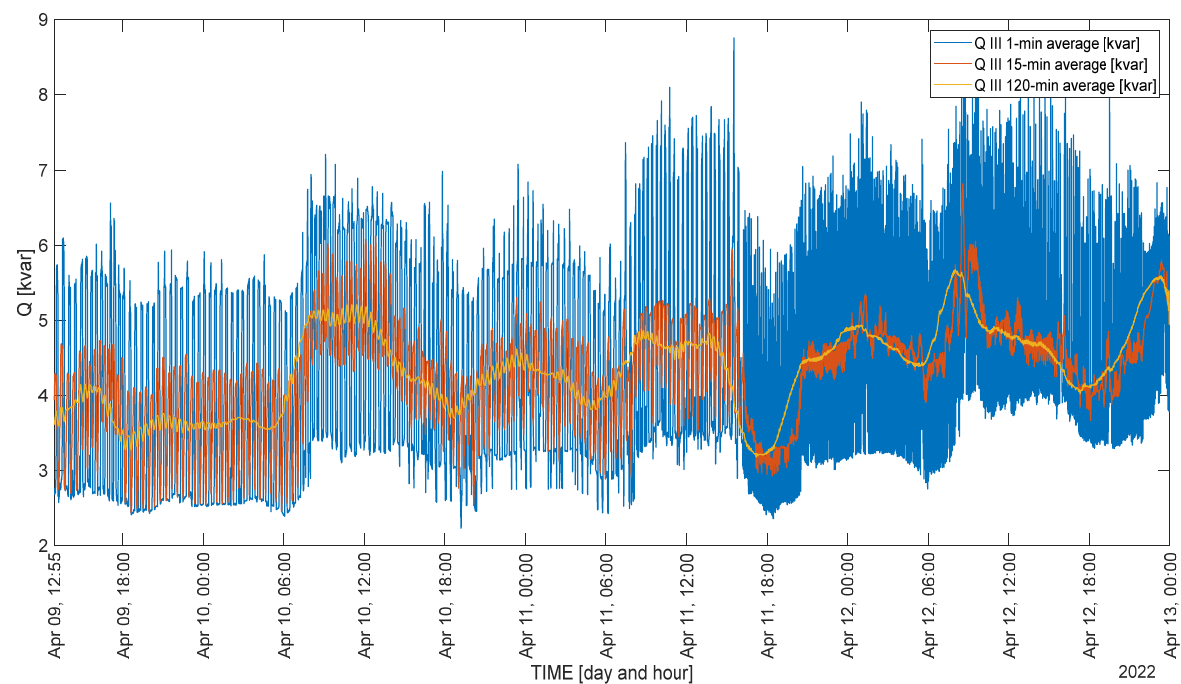
Figure 3. Three-phase active power value as a function of time in the 1st stage of the cycle.